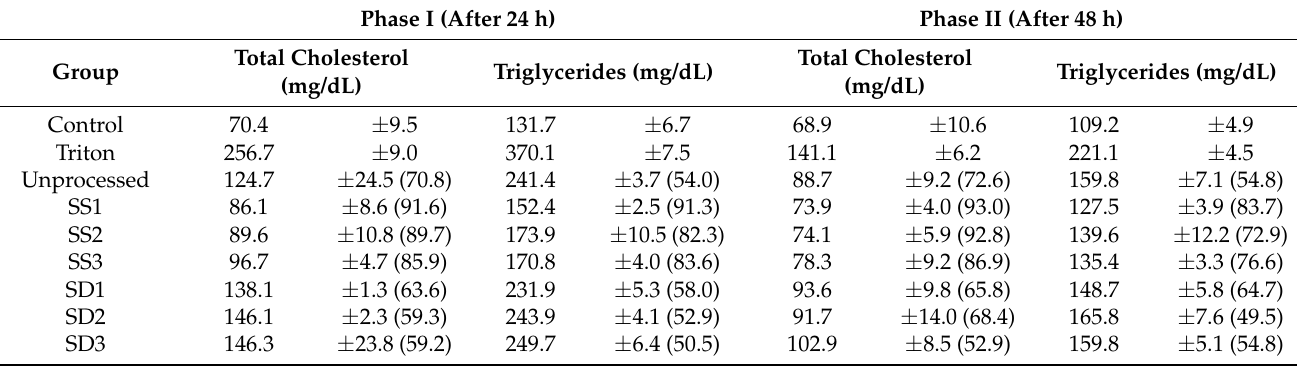
Table 6. The serum lipid profiles in phase I (24 h) and phase II (48 h) for all tested samples (mean ± S.D., n = 4) a .